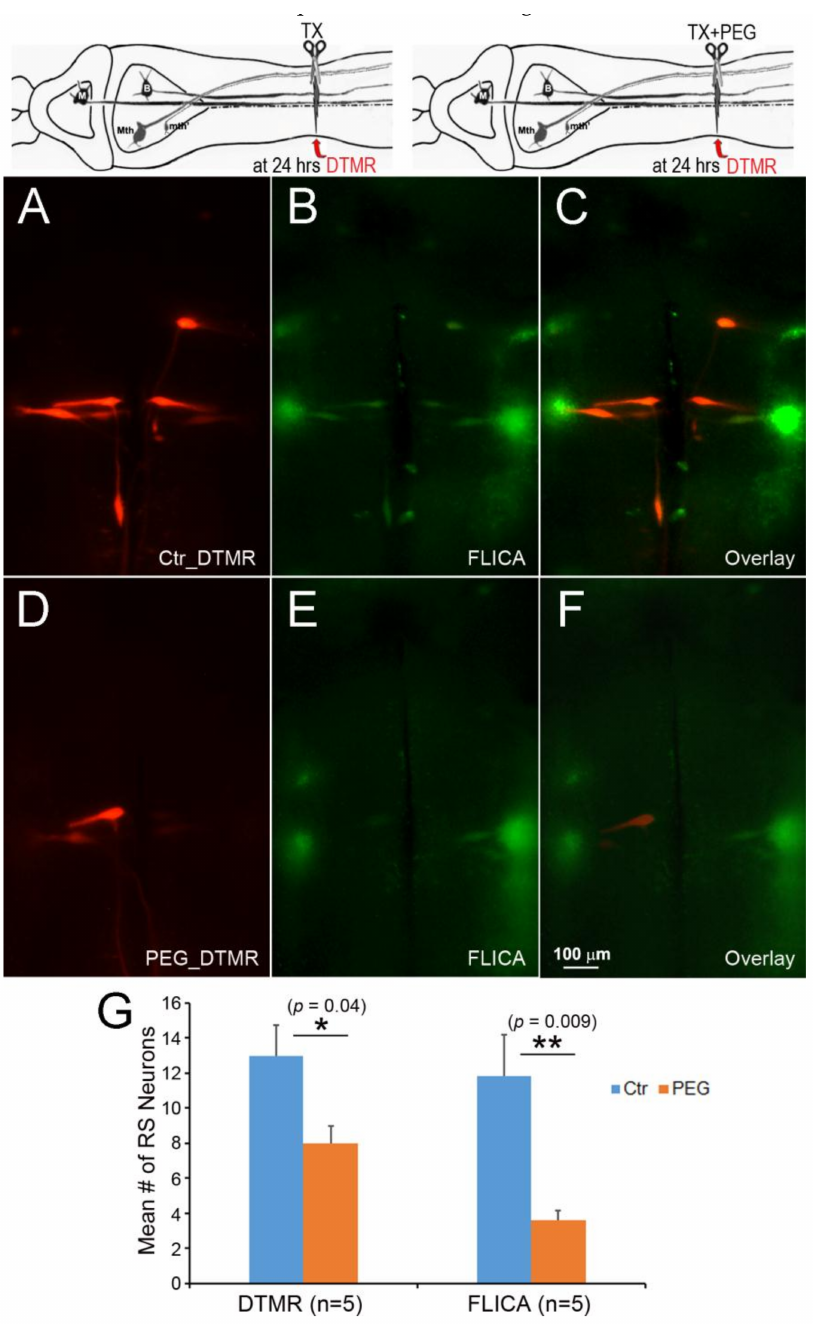
Figure 10. Acceleration of axon resealing with PEG reduced caspase activation. The spinal cords ere transected at 20% BL with or without PEG. At 24 h post-TX, DTMR was applied to the TX site to label neurons whose axons had not sealed ( A , D ); 2 weeks post-TX, the brains were processed by FLICA ( B , E ). PEG reduced the uptake of DTMR by severed RS axons ( A ) versus ( D ), and reduced the number of caspase + RS neurons ( B ) versus ( E ); ( G ) acceleration of axon sealing and reduction of caspase activation by PEG were both statistically